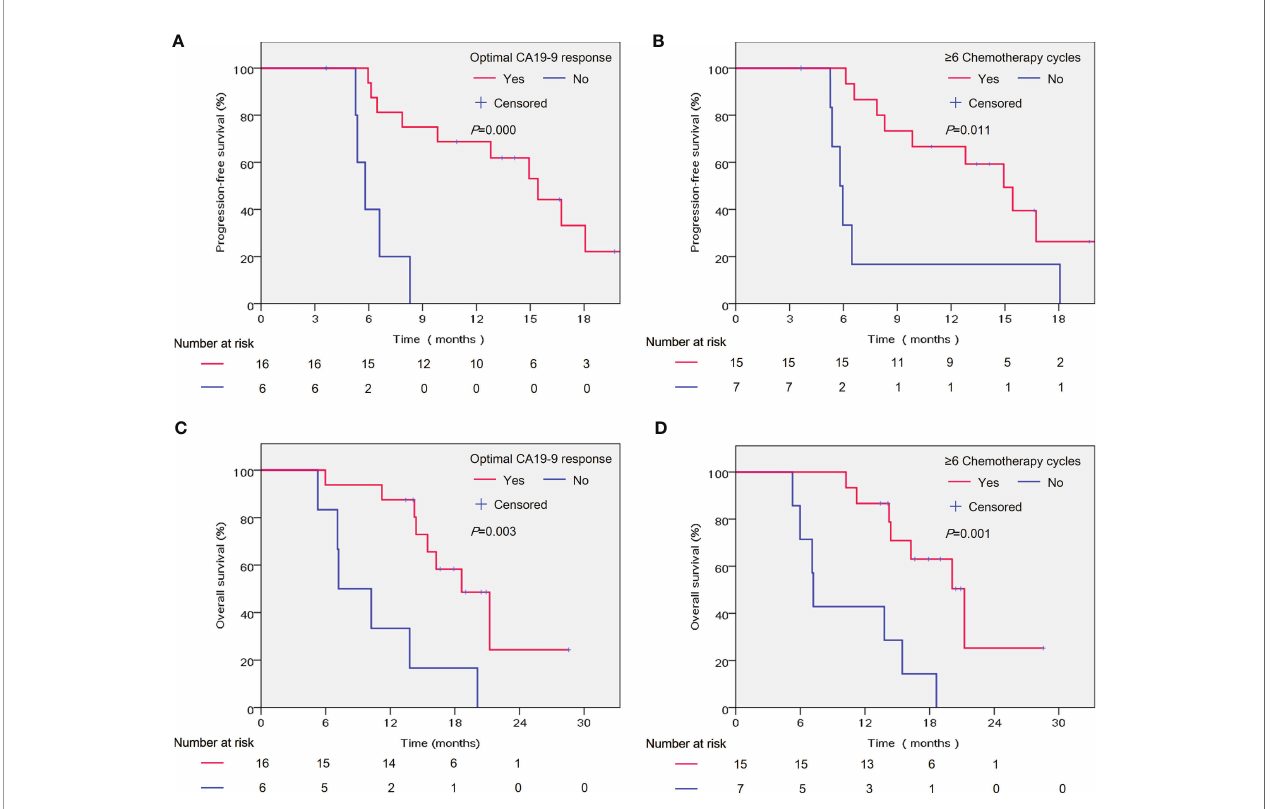
FIGURE 3 | Kaplan – Meier analysis of patient signi fi cant factors in the multivariate analyses and outcomes of patients. PFS was analyzed according to the optimal CA19-9 response (A) and chemotherapy cycles (B) . OS was analyzed according to the optimal CA19-9 response (C) and chemotherapy cycles (D) . PFS, progression-free survival; OS, overall survival. Optimal CA19-9 response: Normalization and/or ≥ 50% decline compared with